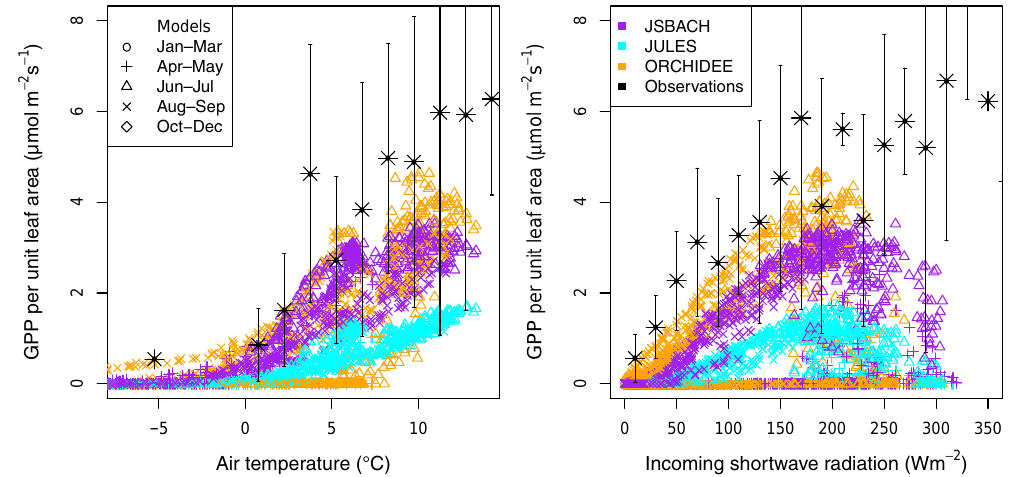
Figure 9. Relationship of normalised GPP (GPP per square metre of leaf) to air temperature and incoming solar radiation. All models and sites are shown, plus observationally derived values using GPP estimated from eddy covariance data and LAI from MODIS (MODIS15A2, 2016); see Sect.